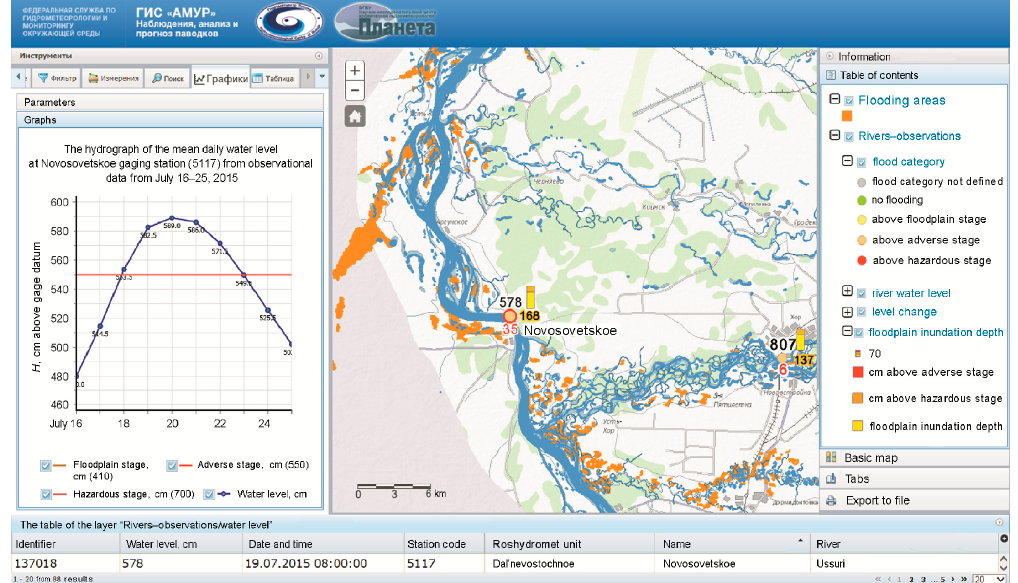
Figure 7. Web-GIS presentation of the July 2015 Ussuri River flood situation: observed water level dynamics at Novosovetskoe (on the left); satellite-based flood map (on the right).